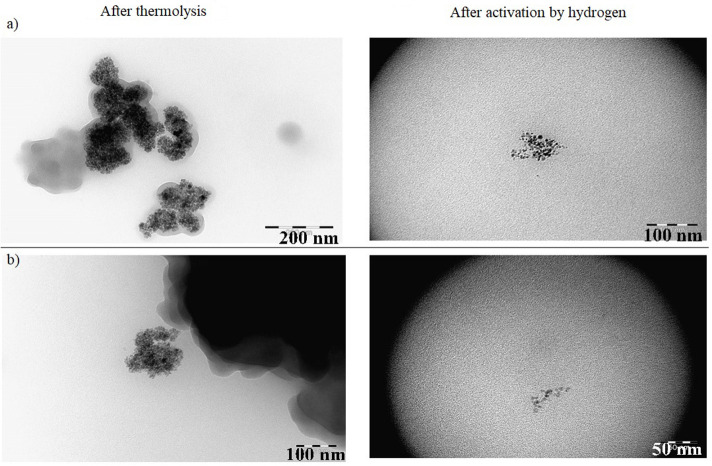
TEM images of samples with (a) ZrO2 and (b) Al2O3 additives.